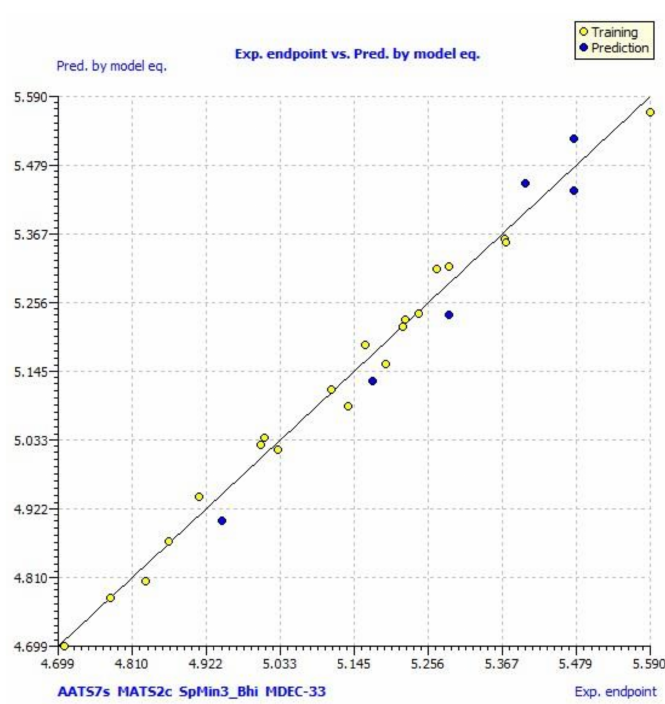
Figure 2. The LMO scatter plot (plot of Kxy vs. Q2 LMO). pIC 50 = 18.2893 − 3.1558 (MATS2c) − 8.6164 (SpMin3_Bhi) − 0.3147 (ETA_EtaP_F) + 0.2471